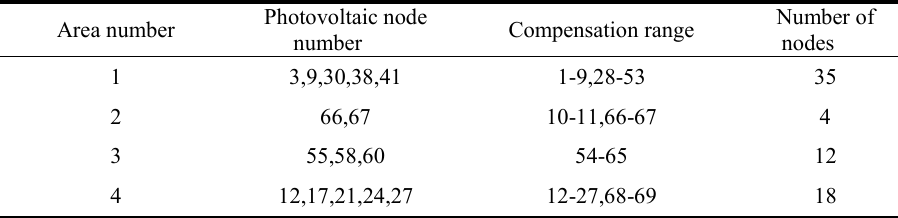
Table 1. Partition result of the system at